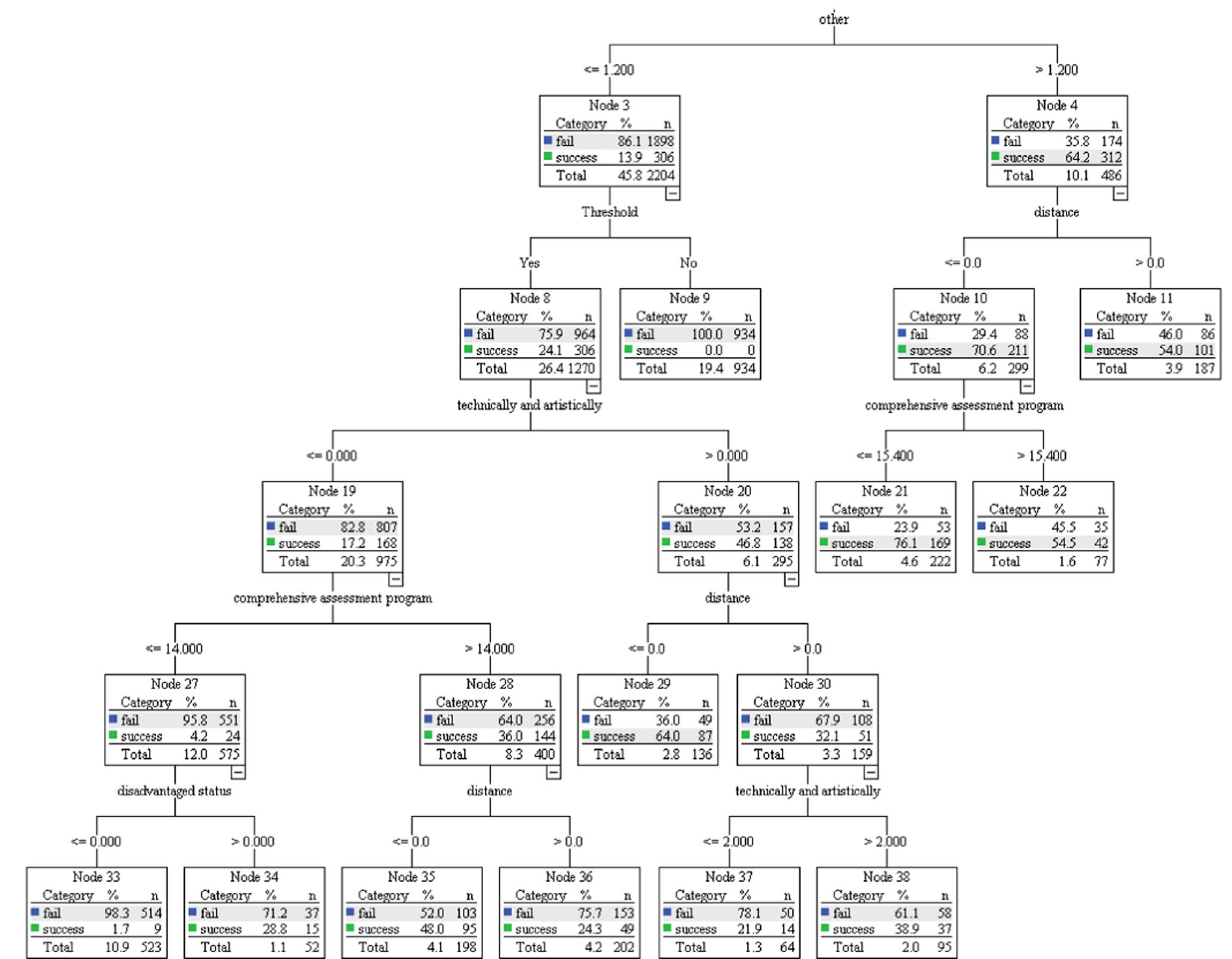
Fig. 5 A sub-tree on left for the training. A sub-tree structure for the training sample in the metropolitan area